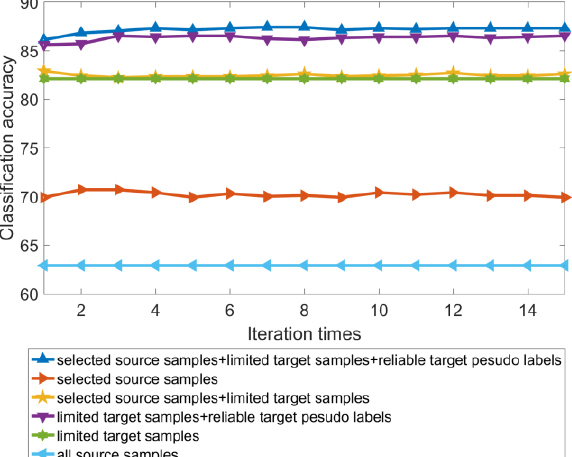
Figure 15. The experimental results of ResNet-18 architecture with 20% training ratio.